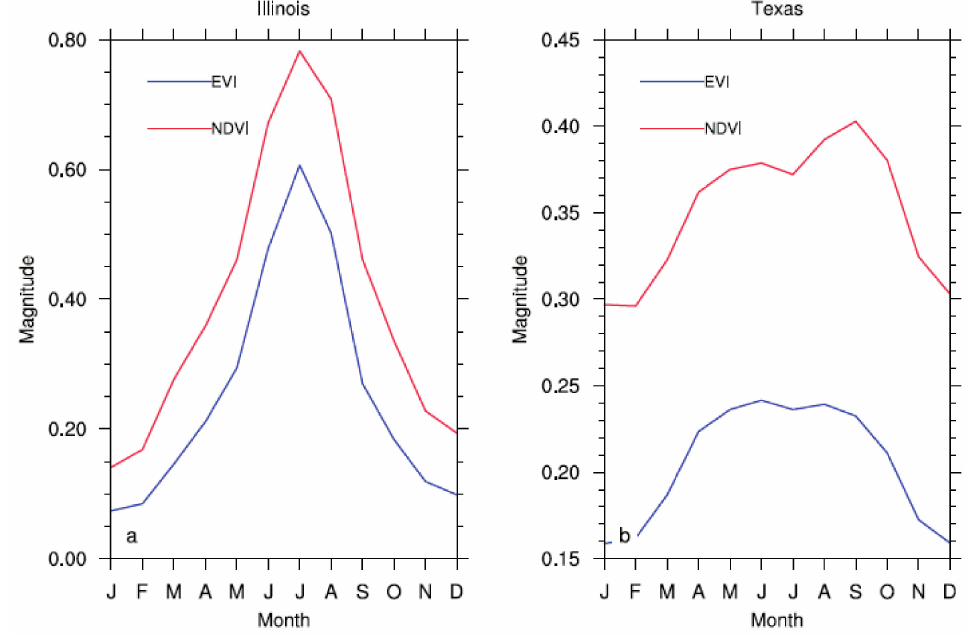
Figure 1. The seasonal cycle of monthly mean NDVI (red) and EVI (blue) averaged over the study region in ( a ) Illinois and ( b ) Texas for the period